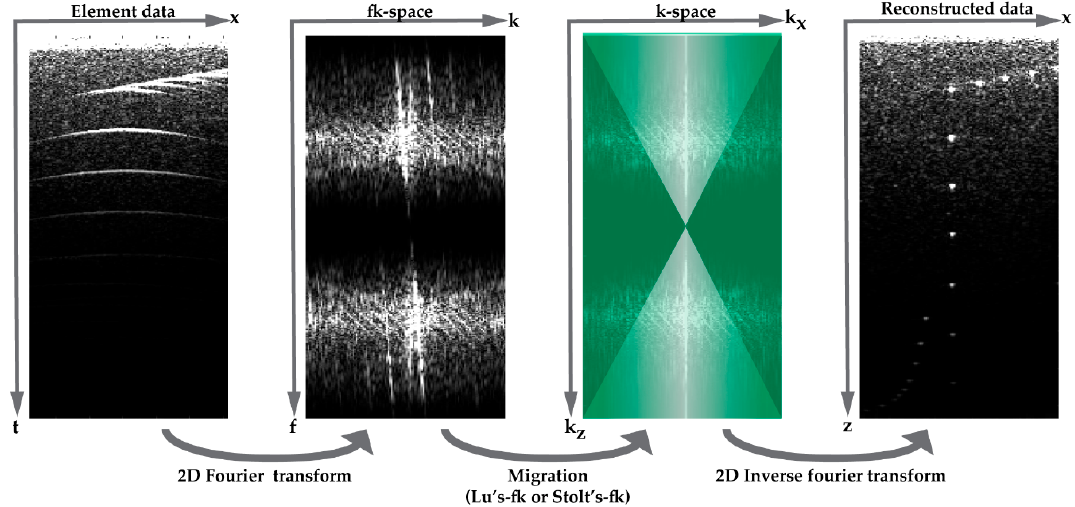
Figure 3. Overview of beam-forming in the fk-space: acquired element data is transformed to the fk-space using 2-D Fourier transform, and Lu’s-fk or Stolt’s-fk migration is applied to convert the data into the k-space. If required, this spectrum can be multiplied by a template (green overlay) to filter the data. Finally, the reconstructed data can be obtained by the 2-D inverse Fourier transform.